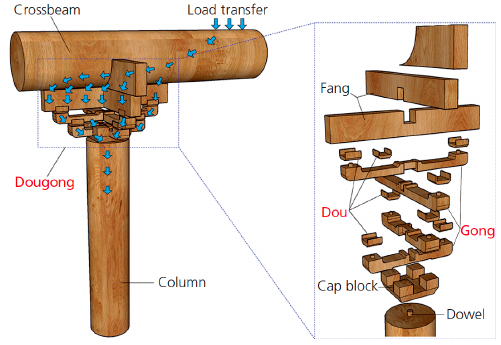
Figure 1. Structure of Dou-gong.